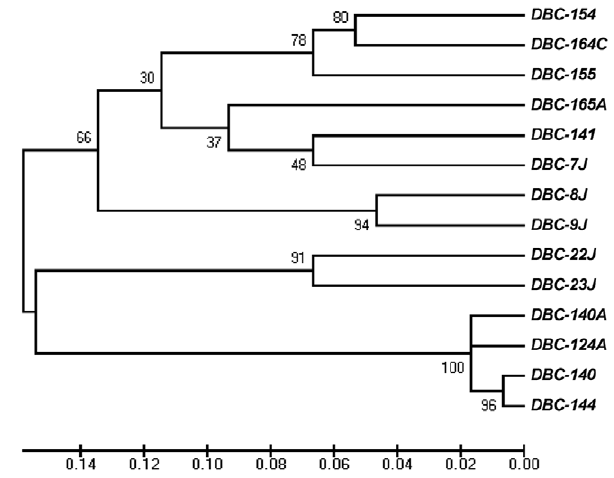
Figure 1. C.albicans strain clustering. Similarities between MLST data were analyzed in terms of p distance with MEGA version 4.0 and nodal support values, after 1000 bootstrap replications, were calculated and are depicted on the UPGMA dendrogram.